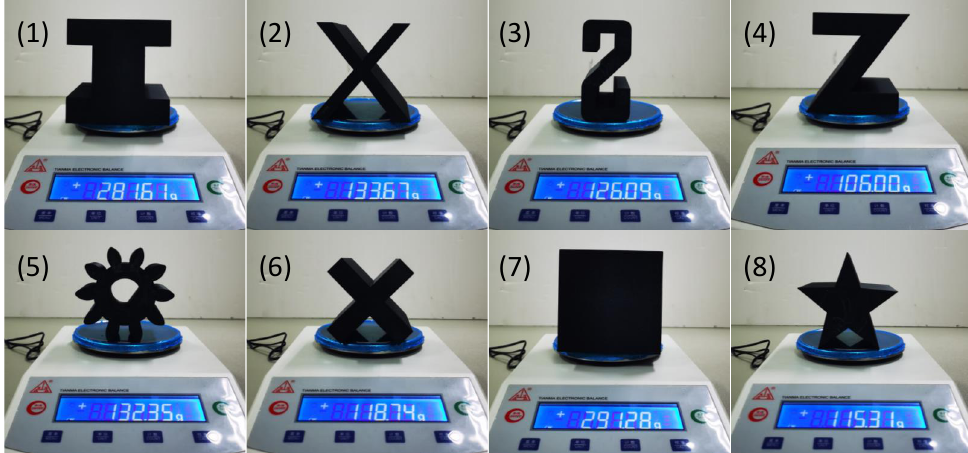
Figure 6. Eight objects were 3D printed to validate the effectiveness of the proposed gripper. (1) H shape, (2) X shape, (3) S shape, (4) Z shape, (5) gear, (6) cross, (7) cube and (8)